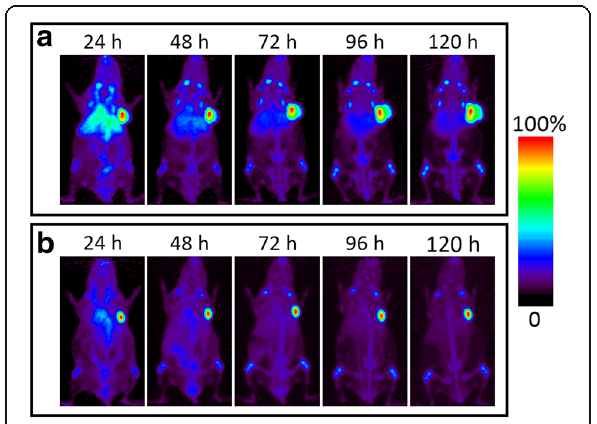
Fig. 2 Maximum intensity projections (MIP) for representative mice administered with 11.4 MBq of [ 89 Zr]Zr-DFO-cetuximab ( a ) and 7.3 MBq of [ 89 Zr]Zr-DFO-trastuzumab ( b ) at different time points after injection in A431( a ) and BT-474 ( b ) tumour-bearing mice ( n =3), respectively. The maximum intensity projections (MIPs) are scaled to the same percentages (100%) for intensity minimum and maximum to appropriately compare the images